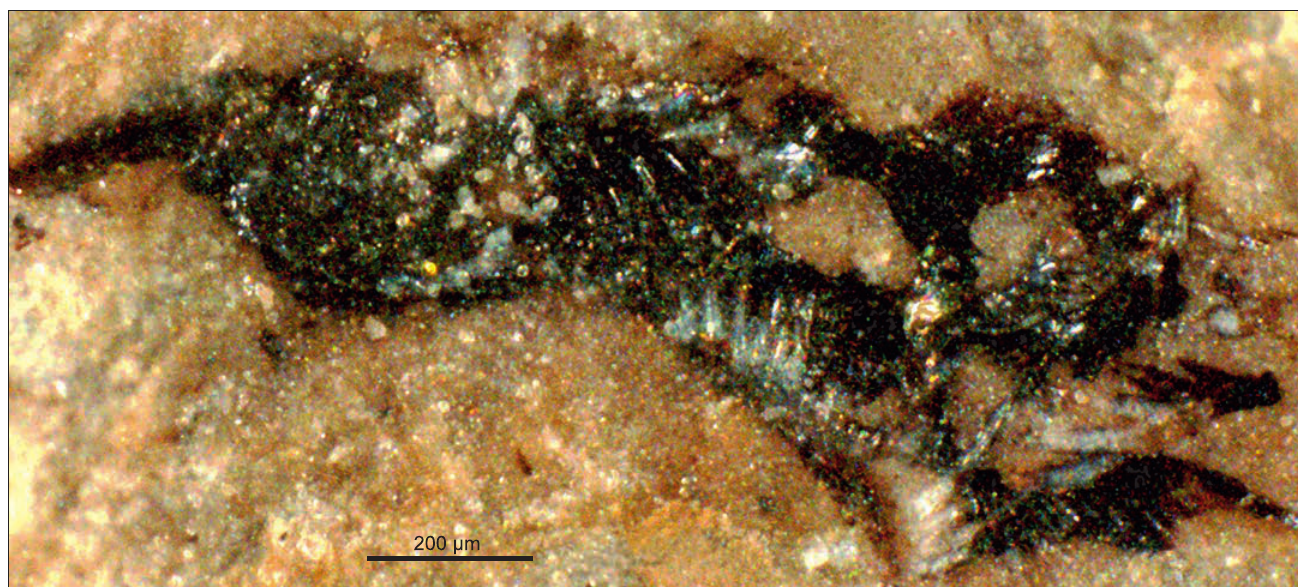
Fig. 2. A black, apparently cartilage structure of a conodontophorid, saving two intact “eye sockets” and numerous conodonts (NHMW 2012/0117/0023); lower Carnian, Upper Triassic, Cave del Predil, NE Italy. NHMW, Museum of Natural History of Vienna,